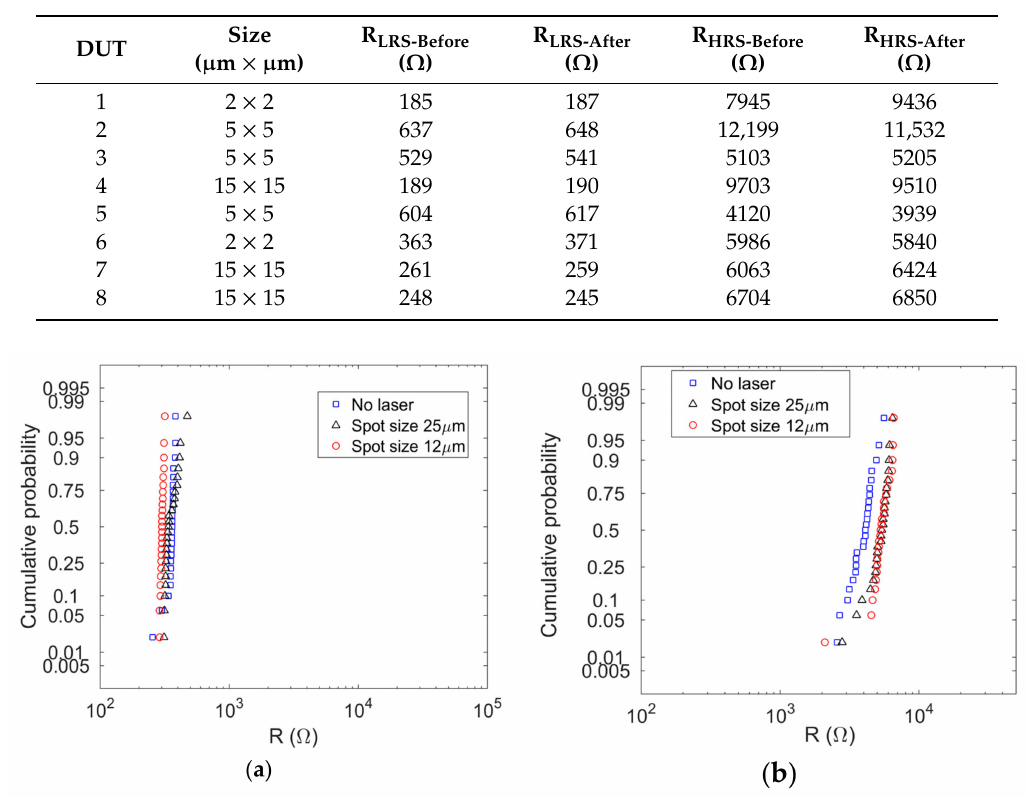
Figure 7. Cumulative distributions of the resistance values for a single RRAM (5 × 5 µ m 2 ) before and after a single laser pulse for di ff erent spot sizes ( a ) RRAM in the LRS; and ( b ) RRAM in the